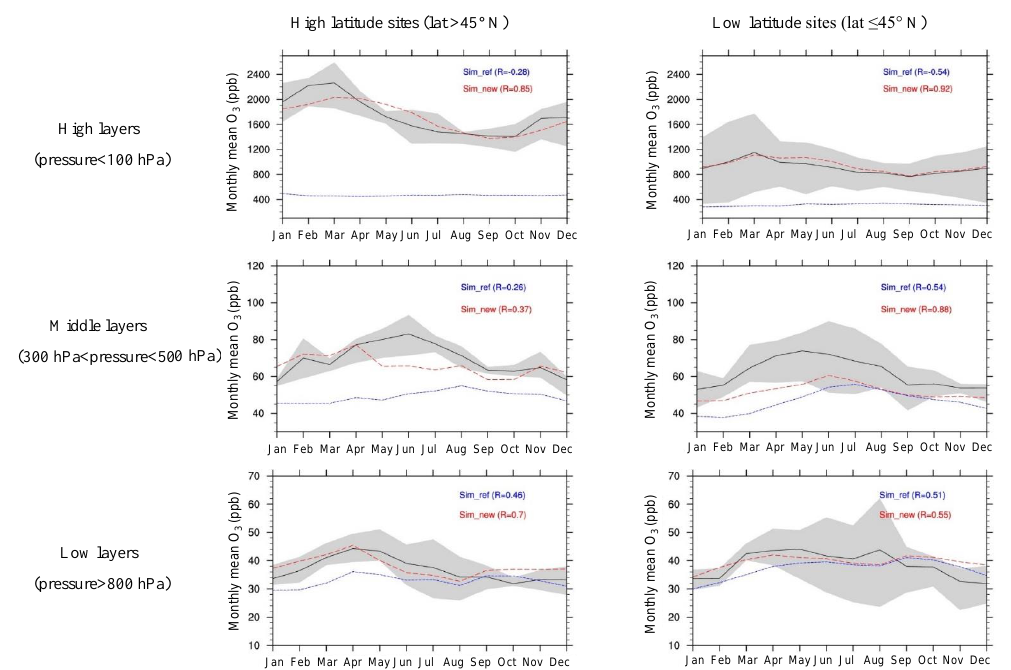
Figure 6. Ozone seasonal variations (44-site averages of monthly mean of measurement time period for each WOUDC site, ppb, January– December 2006, black lines represent observations, blue lines represent Sim-ref, red lines represent Sim-new, grey shadows represent 25th and 75th percentiles of